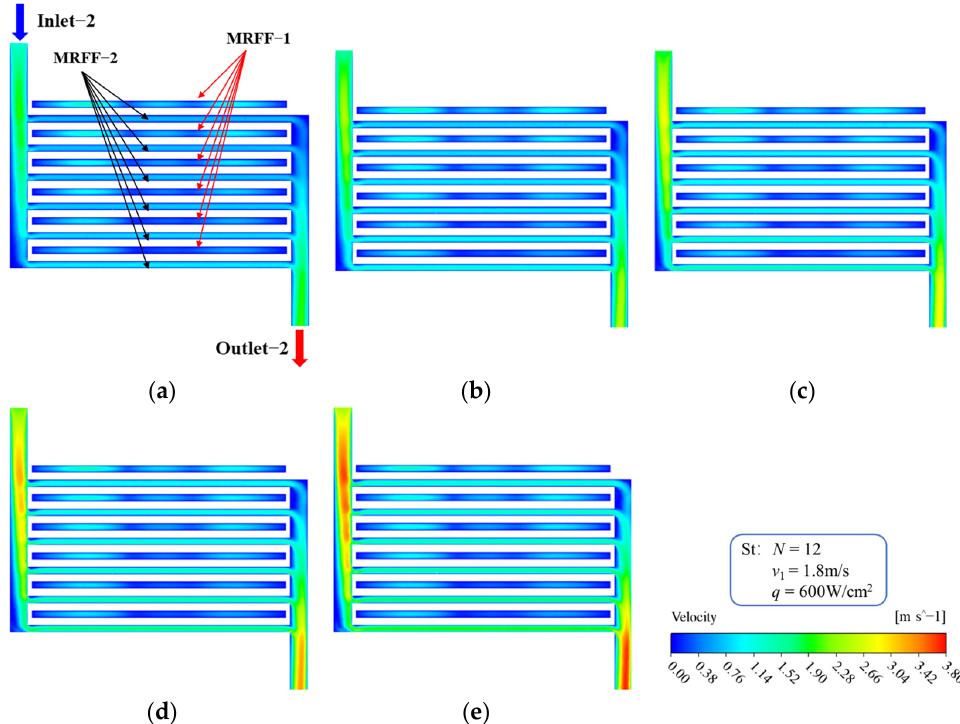
Figure 8. Velocity distribution of microchannel at different inlet − 2 velocities. ( a ) u in − 2 = 1.2 m/s; ( b ) u in − 2 = 1.5 m/s; ( c ) u in − 2 = 1.8 m/s; ( d ) u in − 2 = 2.1 m/s; ( e ) u in − 2 = 2.4 m/s.